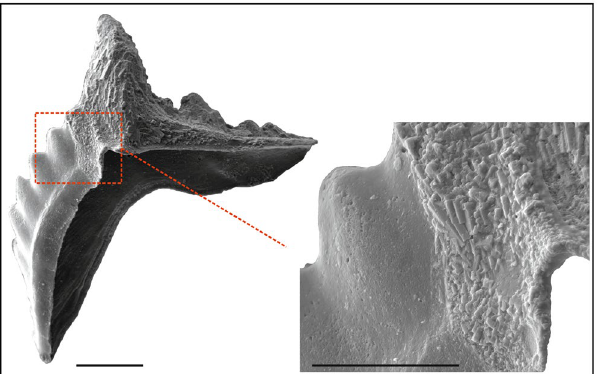
Figure 1. Authigenic apatite crystal overgrowth on conodonts. Scanning electron micrograph images of Amorphognathus sp., Pb element; specimen IPUM 28983, sample W4-2006. Note the sharp contact between the areas with microtexture and the smooth (with no crystal overgrowth) part of the element. Scale bar corresponds to 100 μ m (left) and 50 μ m (right enlargement).